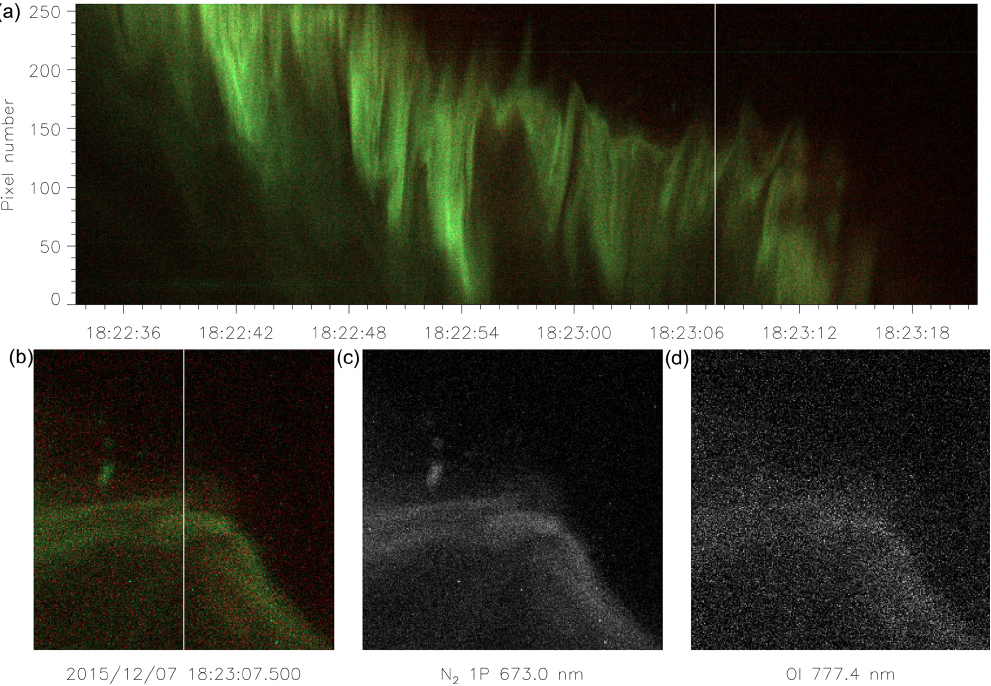
Figure 5. ASK keogram for the event of 7 December 2015 around 18:23:07UTC in panel (a) . ASK1 measuring the 673.0nm emission of the first positive band system of N 2 is visible in (c) , (d) shows the ASK3 measurement of 777.4nm emissions of atomic oxygen, and (b) shows ASK1 in the green/blue channel and ASK3 in the red